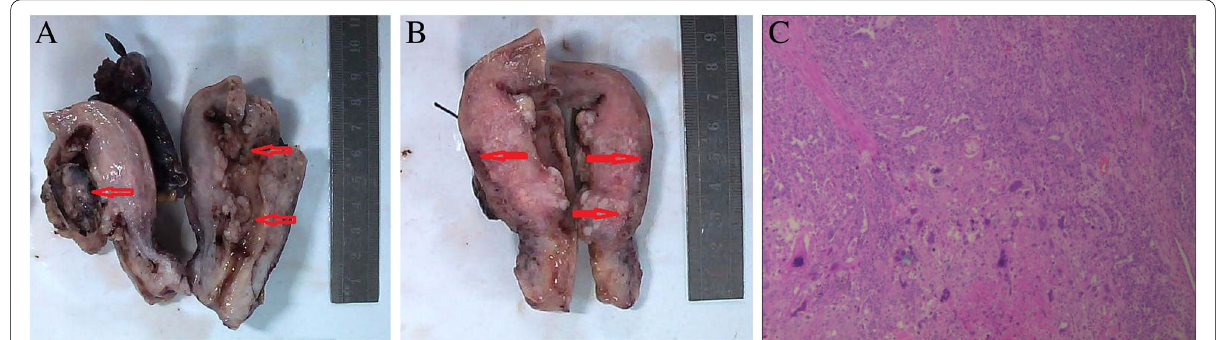
Fig. 1 A Multiple nodular masses (the red arrow) with hemorrhage and necrosis were found in the uterine cavity B : The cut surface was pale gray and brown. The tumor penetrated the entire uterine wall (the red arrow) C : The tumor was consisted of serous carcinoma (upper) and choriocarcinoma (below). (Hematoxylin and eosin stain, original magnification, ×